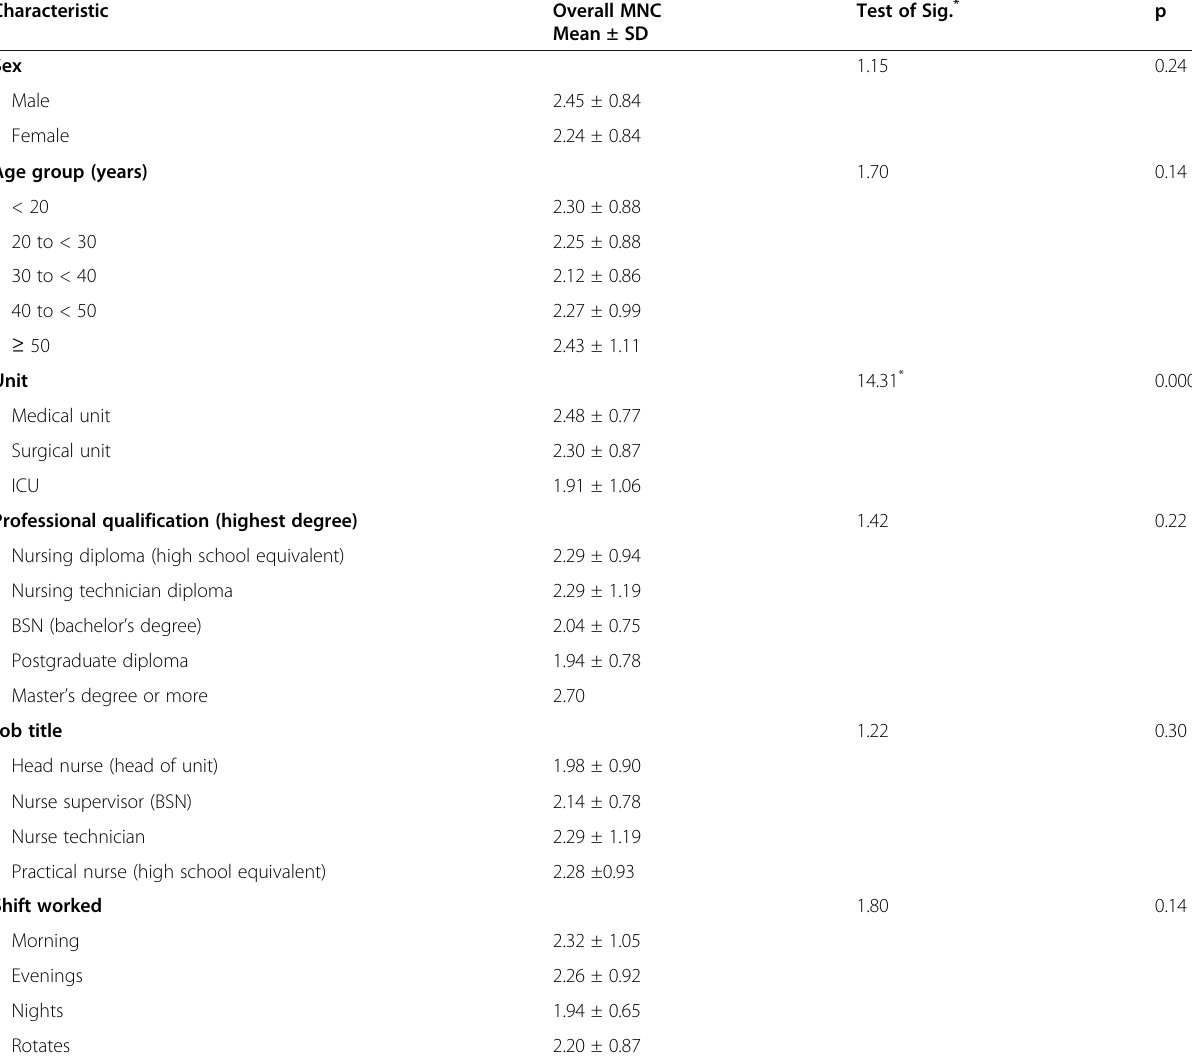
Table 2 Association between overall missed nursing care and demographic and work characteristics